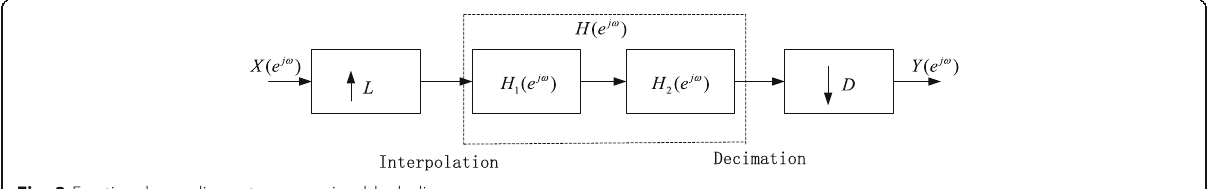
Fig. 3 Fractional sampling rate conversion block diagram